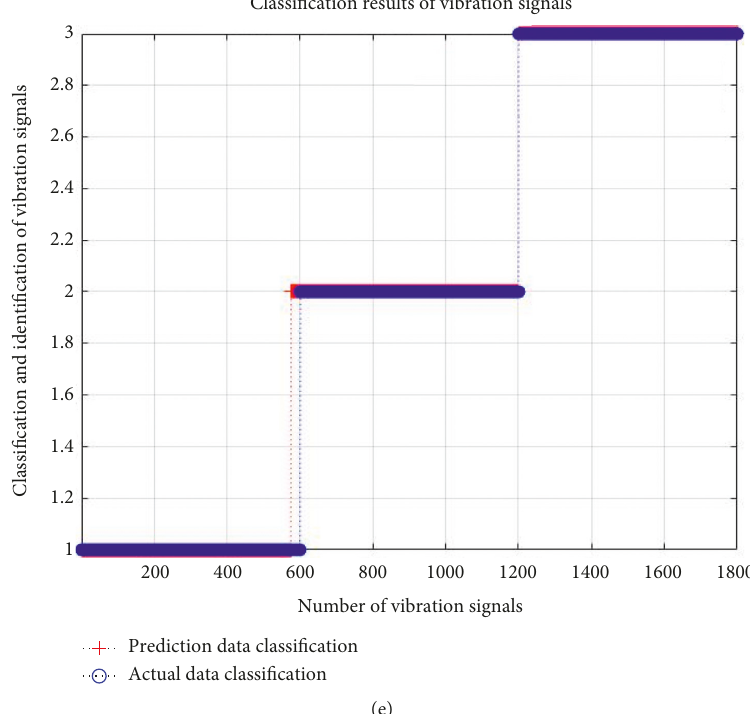
Figure 24: Identification rates of three units based on MRFO-BP neural network. (a) Generator; (b) inlet; (c) middle of the spiral casing; (d) tail of the spiral casing; (e) outlet (comparative